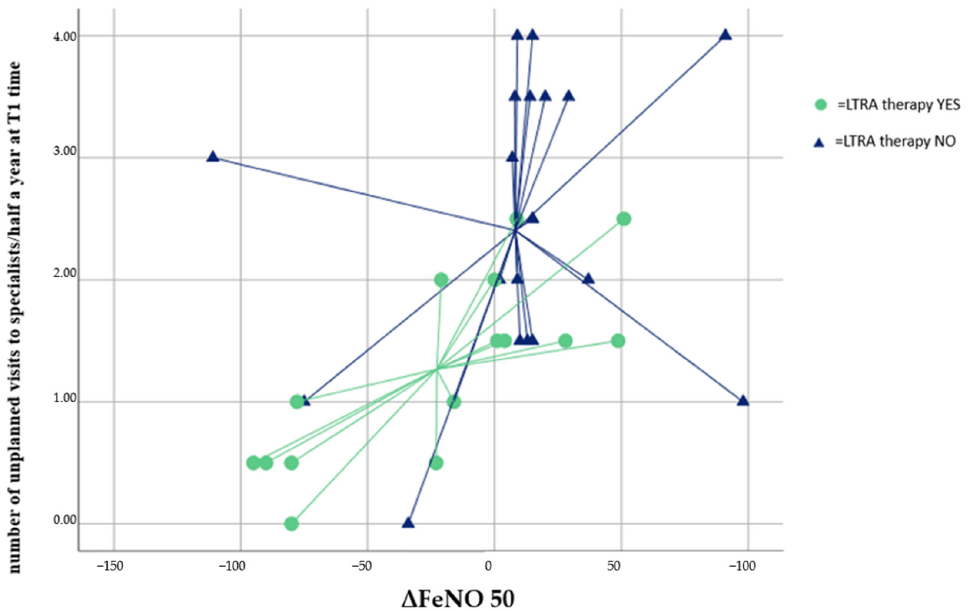
Figure 2. Discriminant Analysis. LTRA therapy discrimination with the number of unplanned specialist visits at time T1 and Δ FeNO 50. FeNO: exhaled nitric oxide; Δ FeNO50: FeNO 50 T0 − FeNO 50 T1. LTRA: leukotriene receptor antagonist. Cross-valid value 66.7%.